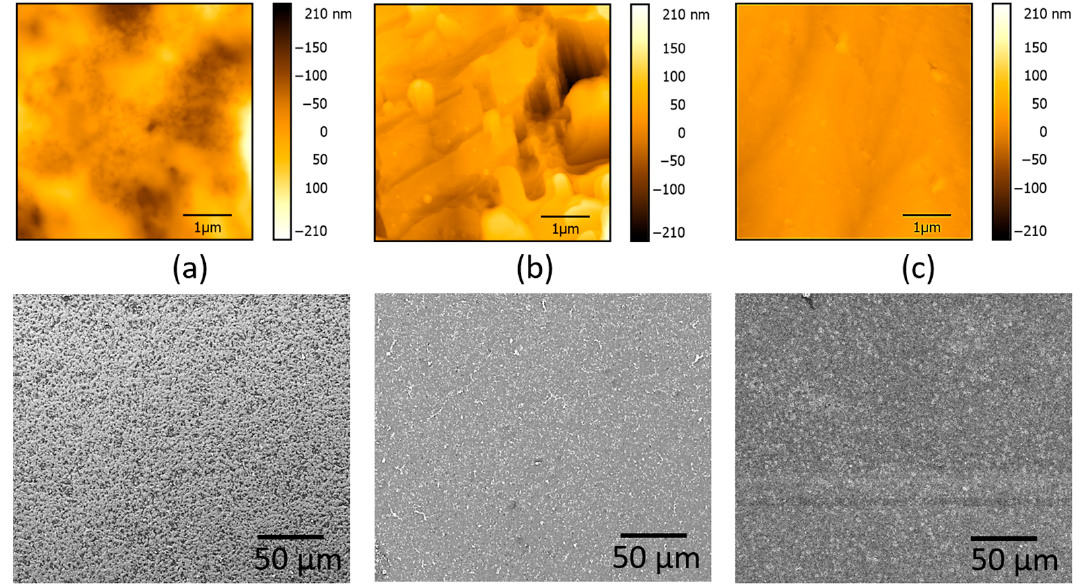
Figure 4. ( a ) AFM and SEM images of the top surface of the electrode prior to LIFT; ( b ) AFM and SEM images of the top surface of the electrode after printing a 25:75 %wt. PEDOT:PSS: GO pixel at 600 mJ/cm 2 without an intermediate triazene polymer layer; the root-mean-square roughness (RMS) value determined from the AFM is 45 nm; ( c ) AFM and SEM images of the top surface of the elec- trode after printing a 50:50 %wt. PEDOT:PSS: GO pixel at 600 mJ/cm 2 without an intermediate tri- azene polymer layer; the RMS value is 11 nm. The transfers are carried out at room temperature and in close contact between the donor and the receiver.